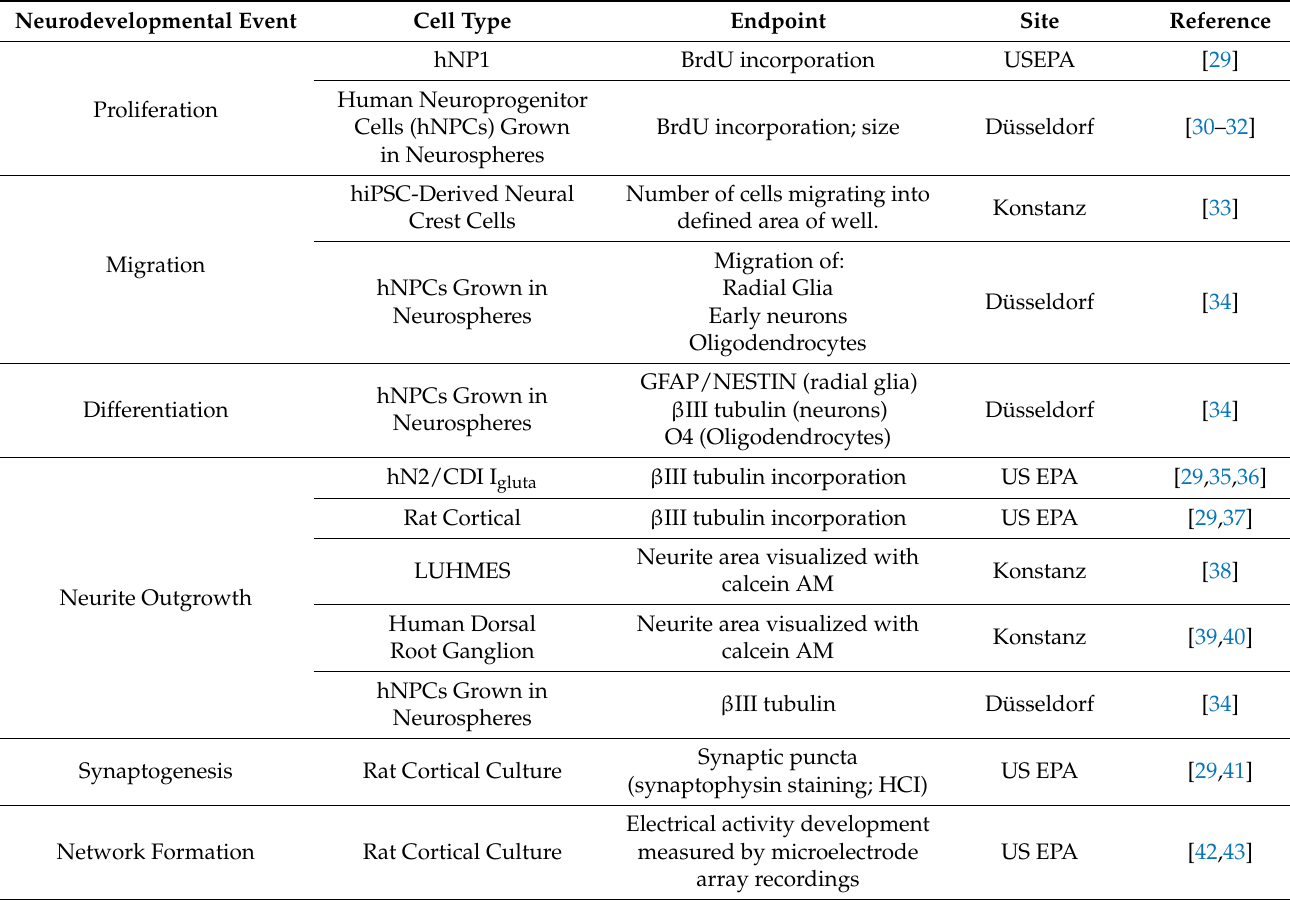
Table 1. Summary of the DNT assays in the